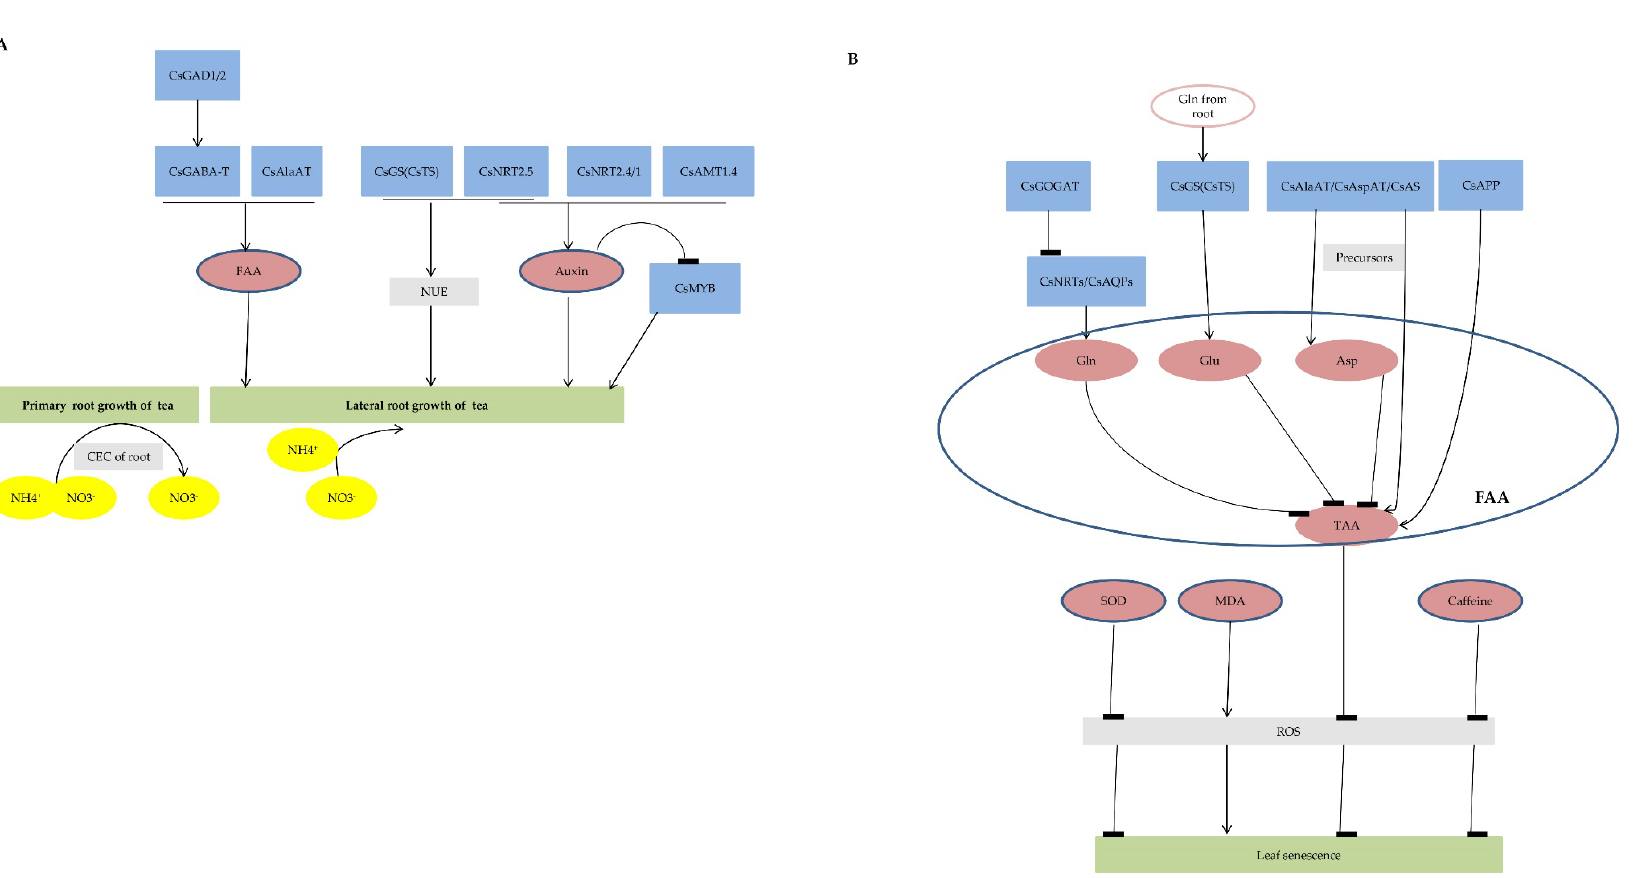
Figure 2. Schematic representation of nitrogen regulation on root system architecture and leaf metabolism. ( A ) The schematic for nitrogen regulation on primary and lateral root growth of tea plant. ( B ) The schematic for nitrogen regulation on leaf metabolism. The yellow box indicates nitrogen or a nitrogen form; the blue box indicates genes involved in the nitrogen response; light red boxes indicate metabolites of tea plant; light gray indicates biological response. Arrows indicate positive regulation. Blunted lines indicate negative regulation. CsGAD1/2 , glutamic acid decarboxylase 1/2 in Camellia sinensis ; CsGABA-T , γ -aminobutyric acid in Camellia sinensis; CsAlaAT, alanine aminotransferase in Camellia sinensis; CsGS(CsTS), glutamine synthetase (theanine synthetase) in Camellia sinensis ; CsNRT2.5 , nitrate transporter 2.5 in Camellia sinensis ; CsNRT2.4/1 , nitrate transporter 2.4/1 in Camellia sinensis ; CsAMT1.4 , ammonium nitrogen transporter 1.4 in Camellia sinensis ; CsMYB , MYB transcription factors in Camellia sinensis ; GsGOGAT , glutamate synthase in Camellia sinensis ; CsAAP , amino acid permeases in Camellia sinensis .